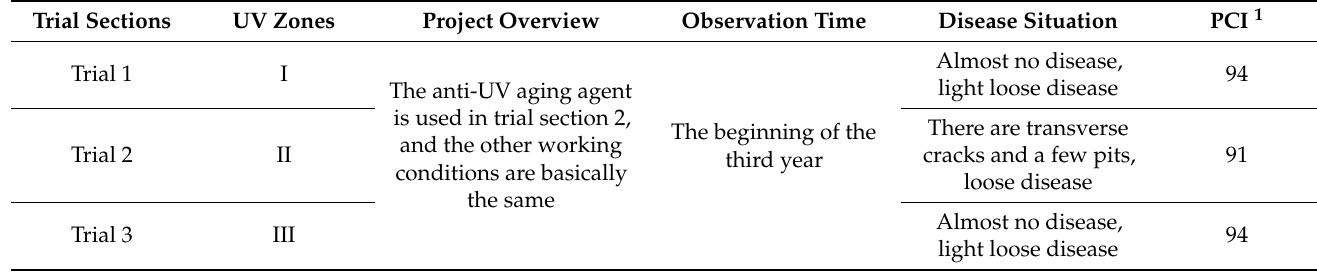
Table 8. The disease situation of each trial